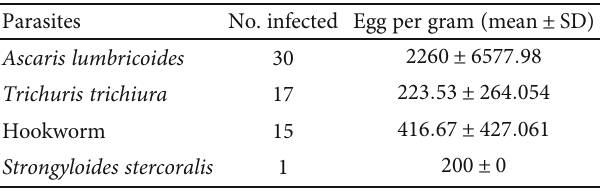
Figure 2: Prevalence of single and mixed parasitic infections. Table 7: Intensity of infection of helminth parasites. Table 8: Degree of